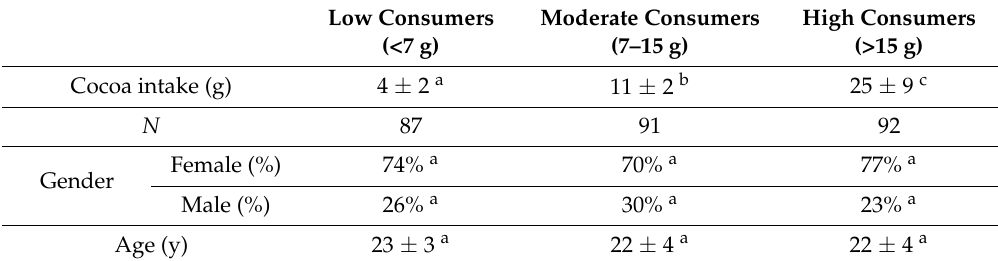
Table 1. Gender and age distribution of low, moderate and high cocoa consumers. Results are expressed as percentage or mean ± standard deviation of the mean (SDM). Different letters mean statistical difference.